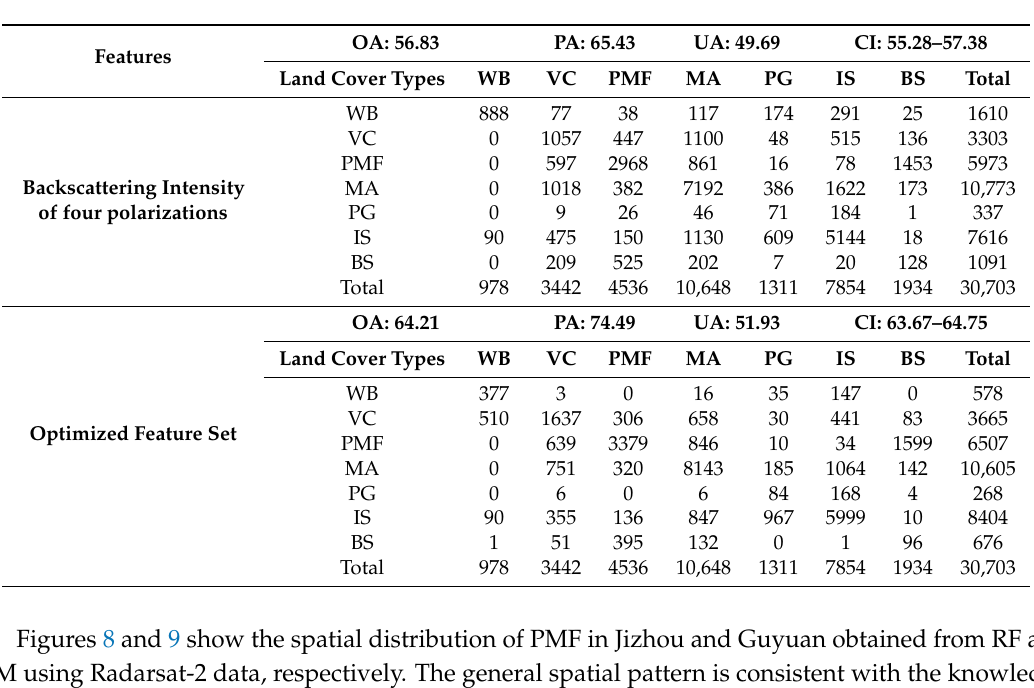
Table 8. The confusion matrix from RF in Guyuan.